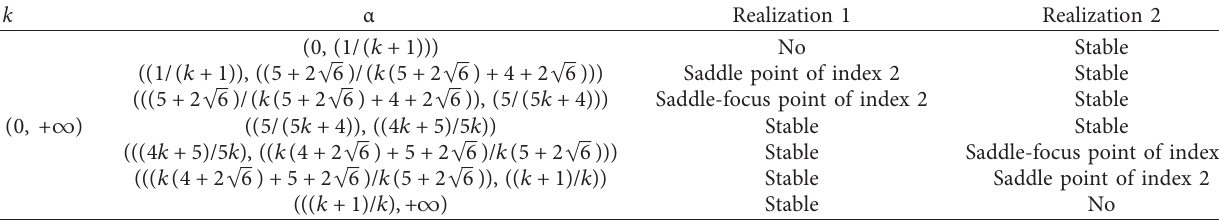
Table 1: Criterion for scenario 1 (( k is fixed, α is control parameter, and k > 0).